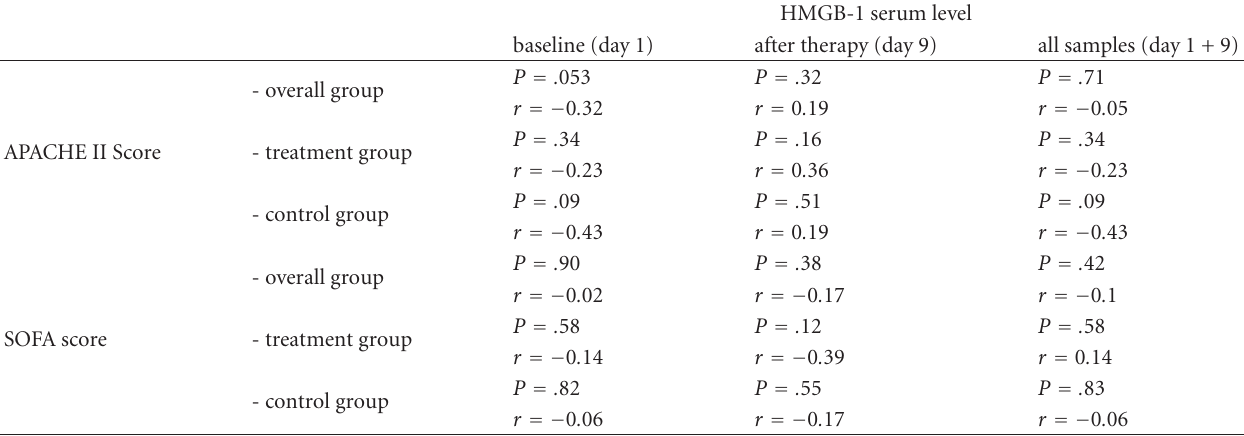
Table 4: Correlation analysis of systemic HMGB-1 levels with indices of disease